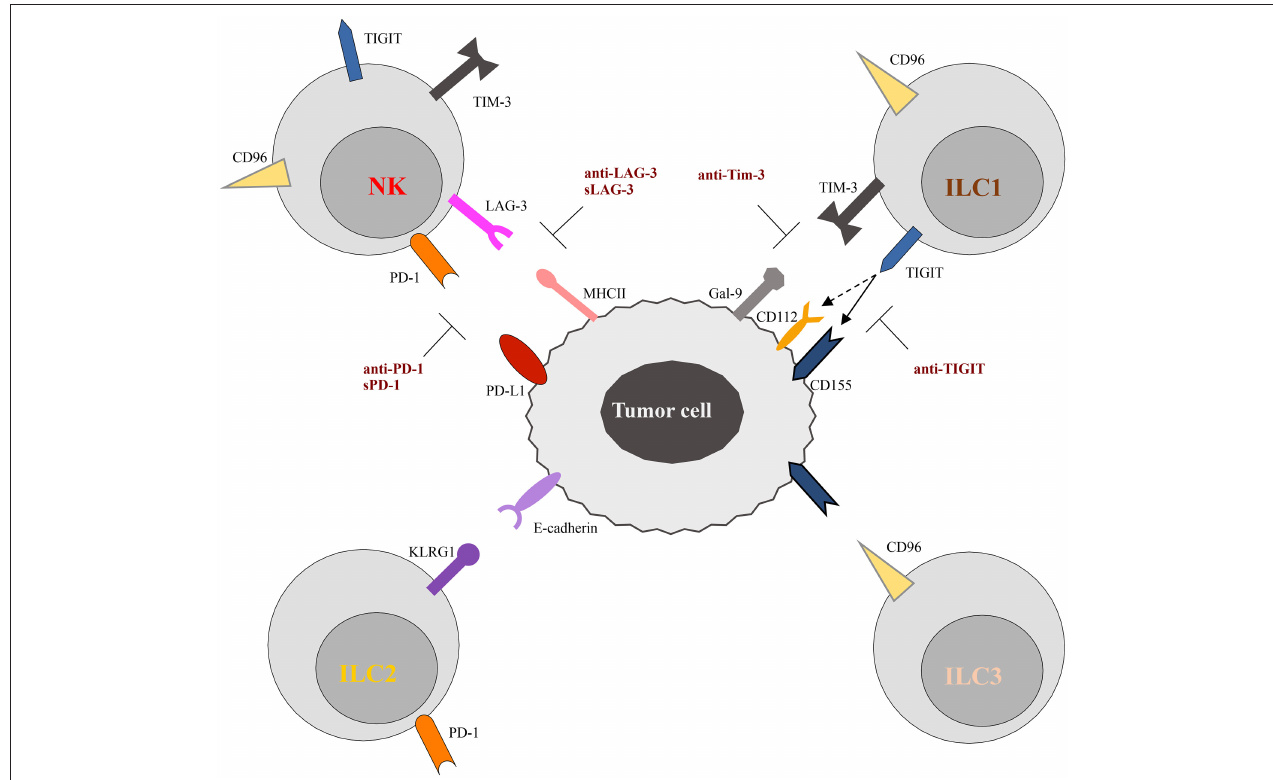
FIGURE 2 | Schematic representation of checkpoint receptors and their ligands expressed by ILC and tumor cells, respectively. NK cells express multiple immune checkpoint receptors, such as PD-1, TIM-3, Lag-3, TIGIT, and CD96. ON the other hand, these checkpoint receptors are instead differentially expressed by ILC subsets. Thus, TIGIT and TIM-3 have been detected only on ILC1 cells, while CD96 is expressed on both ILC1 and ILC2. Surface expression of KLRG1 and PD-1 appears to be restricted to ILC2 cells. The inhibitory ligands expressed by tumor cells, specifically interact with the checkpoint receptors preventing cells activation. However, different therapeutic approaches, aimed to block receptor/ligand interactions, have been demonstrated to restore the anti-tumor activity of immune cells, as illustrated in the Figure. The solid and dotted arrows indicate the strong and weak binding affinity of TIGIT for the different ligands,